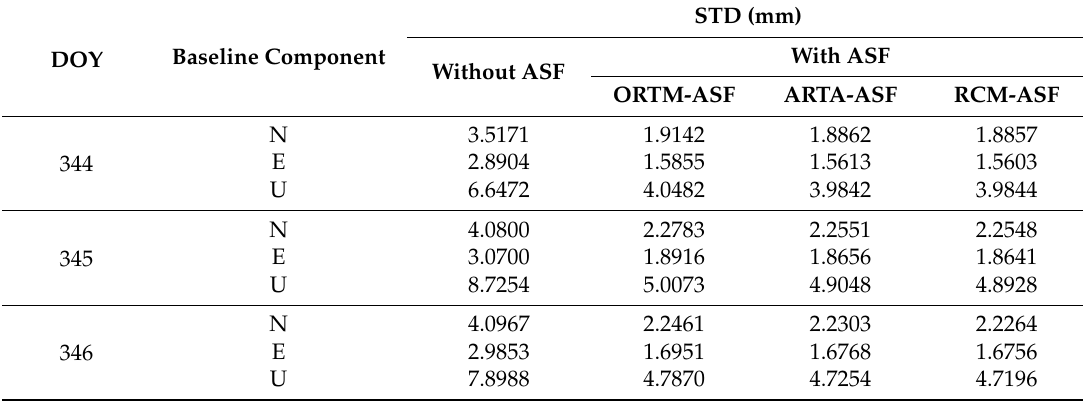
Table 2. STD of time series of baseline components estimated from observables with and without ASF correction (Including PRN 13).